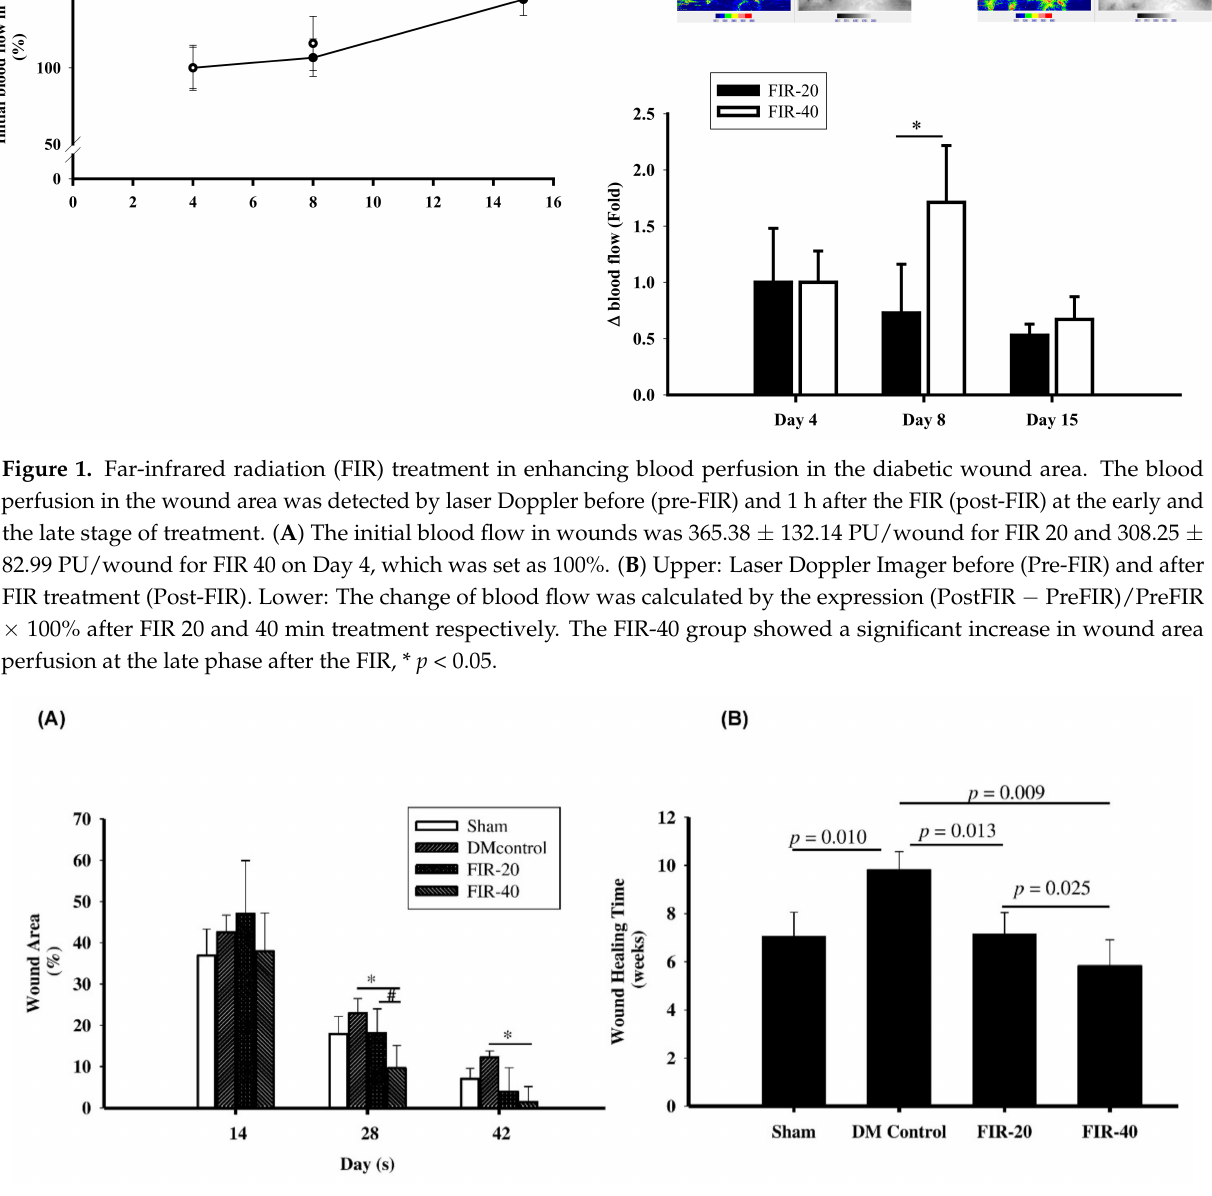
Figure 2. Far-infrared radiation (FIR) in accelerating wound healing in diabetic rats. ( A ) Wound size difference. Compare with DM, * p < 0.05; FIR-20 vs. FIR-40, # p < 0.05. ( B ) Average complete healing time. The complete wound healing time was significantly faster in the FIR group with 20 min (FIR-20) and 40 min (FIR-40) than the diabetic control group without treatment ( p < 0.001). Nonetheless, the wound healing time in the FIR-20-treated group was still significantly longer than that in the FIR-40-treated rats with two sessions ( p =